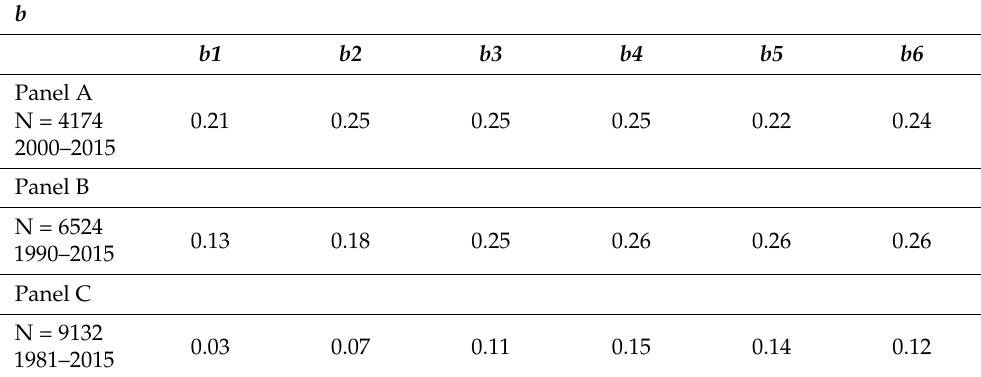
Table 3. Multiple variance-ratio tests of the gold price series: January 1981 to December 2015; b1, b2, . . . , b6 show subsamples of different lengths that increase from b1, b2 , . . . , b6 . p -values are reported for the null hypothesis that the gold price series follow a random